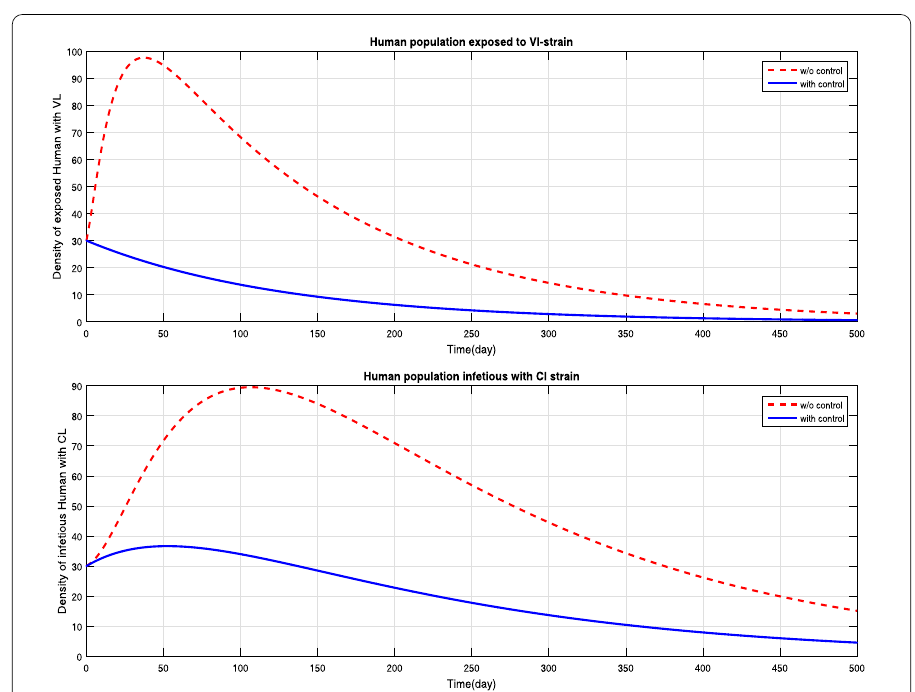
Figure 3 Comparison of behaviors with and without control in case of E 2 and I 1